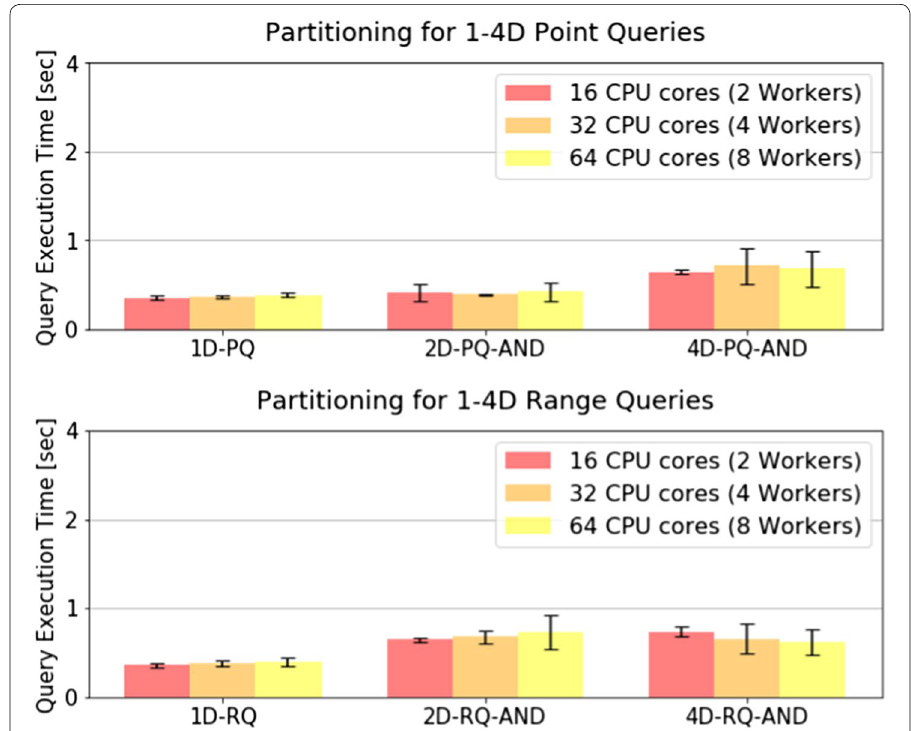
Fig. 6 Response times for one- and multi-dimensional point and range queries against partitioned attributes on the synthetic dataset. The x-axis indicates the dimensionality of the executed query, i.e. 2D-RQ-AND refers to a 2D range query of the form WHERE p1 = X AND p2 =